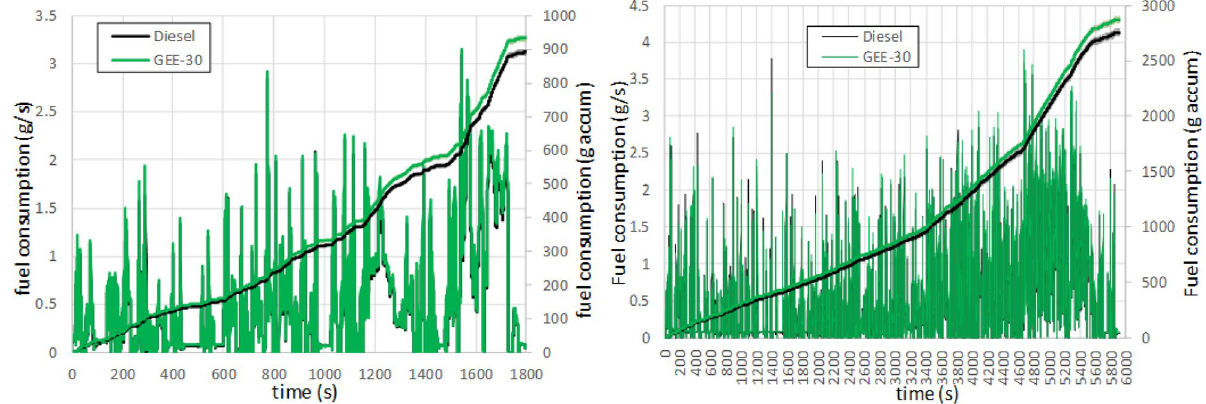
Figure 3. Instantaneous and accumulated fuel consumption along WLTC (left) and RDE Prior to each test, a DPF regeneration and a LNT purge were triggered from the ECU software (to ensure the same aftertreatment conditions at the beginning of the tests), followed by at least 8 h soaking period. All tests were repeated at least three times. Average values and 90% confidence intervals were obtained for all instantaneous results and the confidence intervals were shadowed around the average accumulated values in the figures pre-